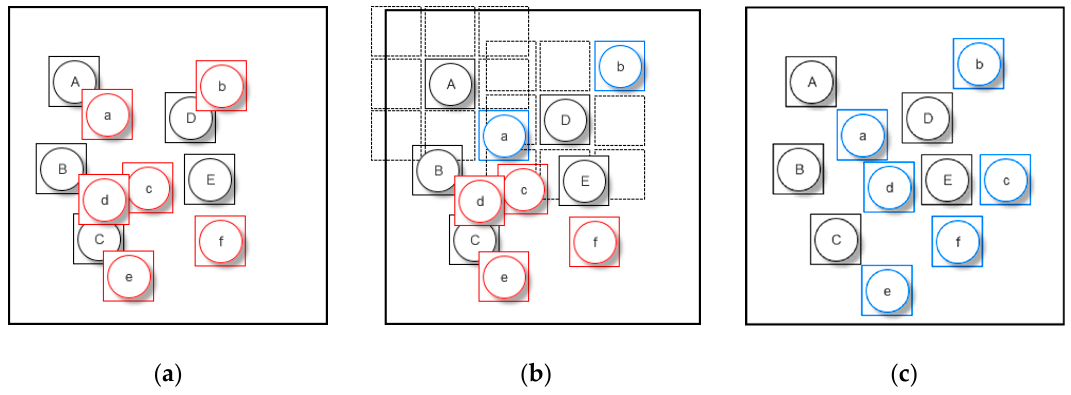
Figure 6. A simple example is used to explain the displacement process: ( a ) original state; black symbols have been added to the map and red symbols need to be processed; ( b ) blue symbols have been processed; ( c ) all the symbols have been added to the map.